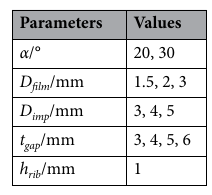
Table 4. Numerical model geometric